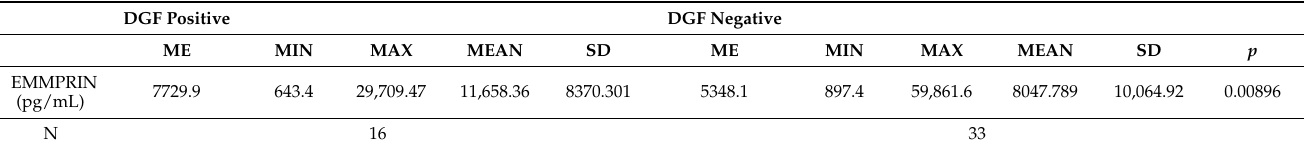
Table 4. EMMPRIN values in in DGF POSITIVE and DGF NEGATIVE